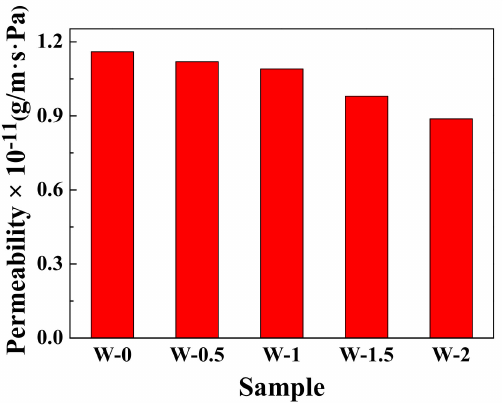
Figure 9. Water vapor permeability of 60SiO 2 / rGO / NR composites with di ff erent rGO contents.